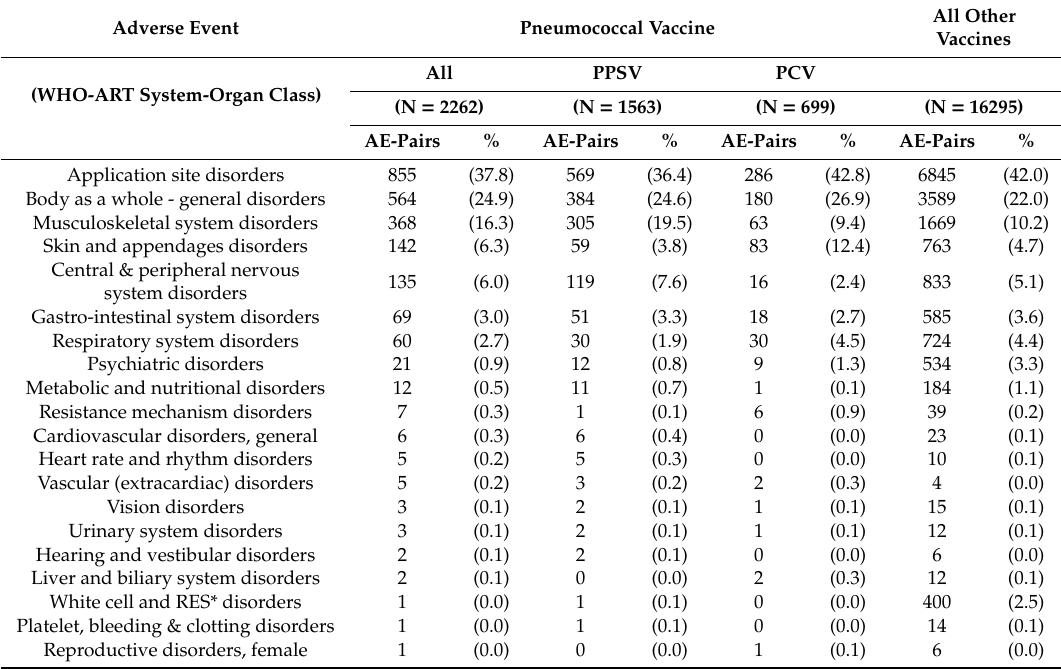
Table 2. The frequency of adverse events for pneumococcal vaccine and all other vaccines from 1988 to 2017. Adverse